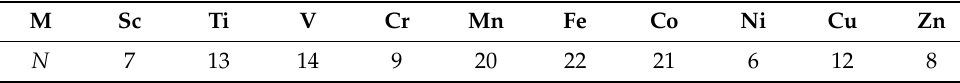
M Sc Ti V Cr Mn Fe Co Ni Cu Zn N